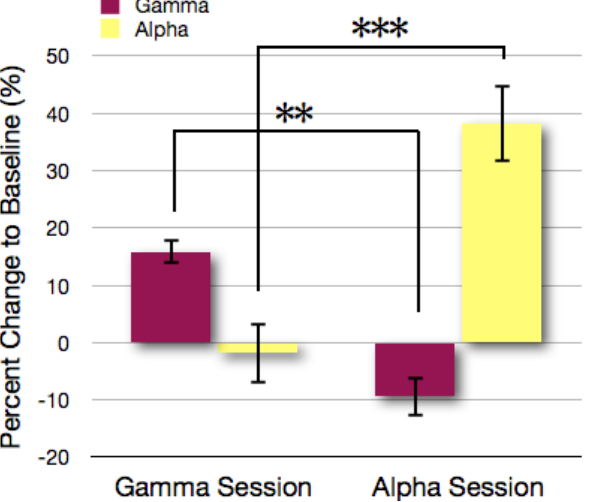
Figure 4. Training success for each volunteer as percent change to day one for the power values separate for each frequency band. For the gamma band, four subjects showed a positive effect, two showed a slight negative effect and two volunteers showed no training effect. For the alpha band, two different volunteers were not successful in enhancing the power across